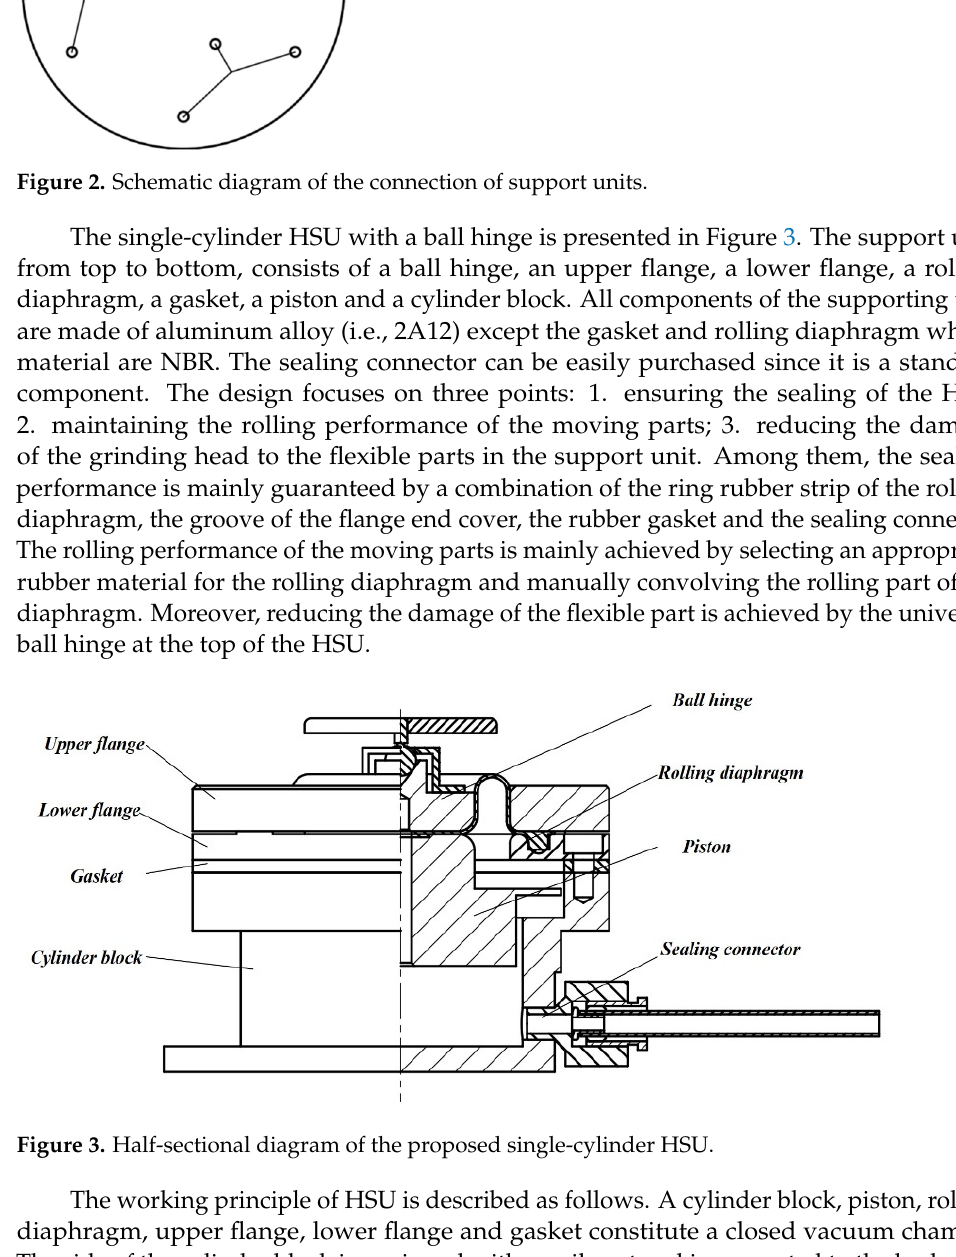
Figure 2. Schematic diagram of the connection of support units.